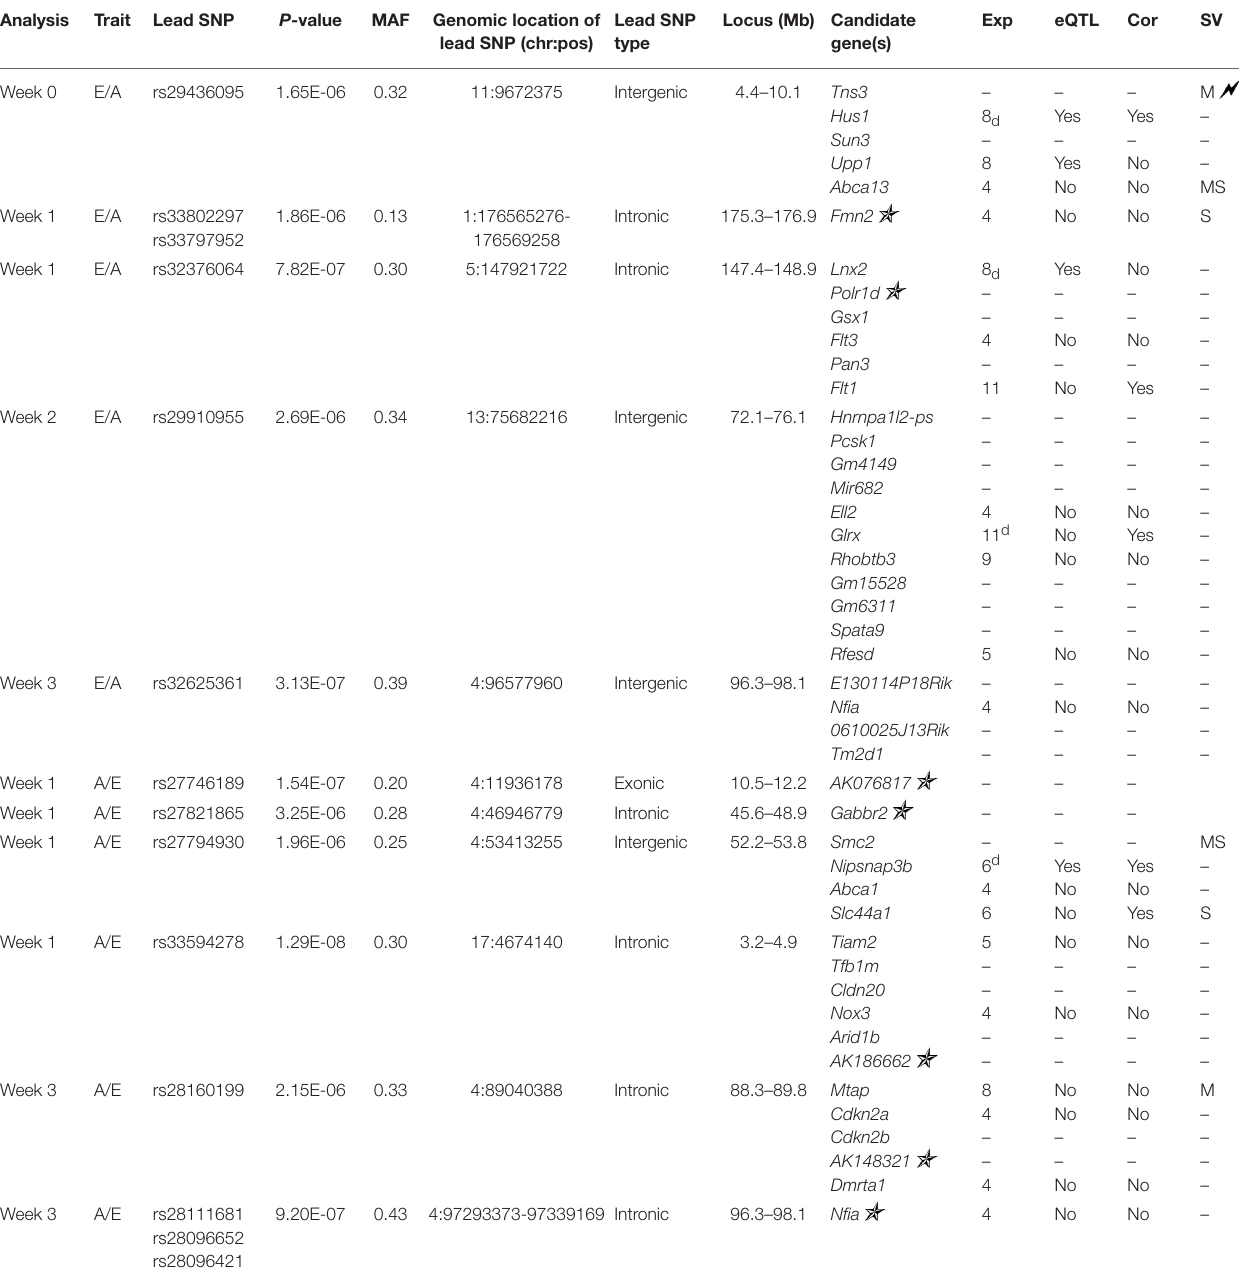
TABLE 2 | Significant echocardiographic diastolic function loci.